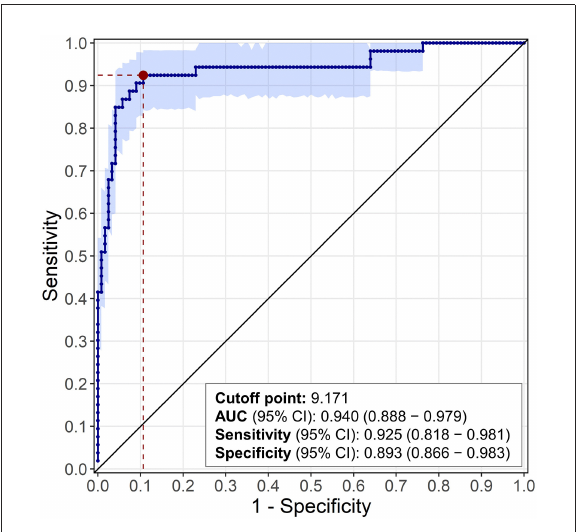
FIGURE2 Graphical plot of the ROC curve. Sensitivity = true positive rate; 1 – specificity = false positive